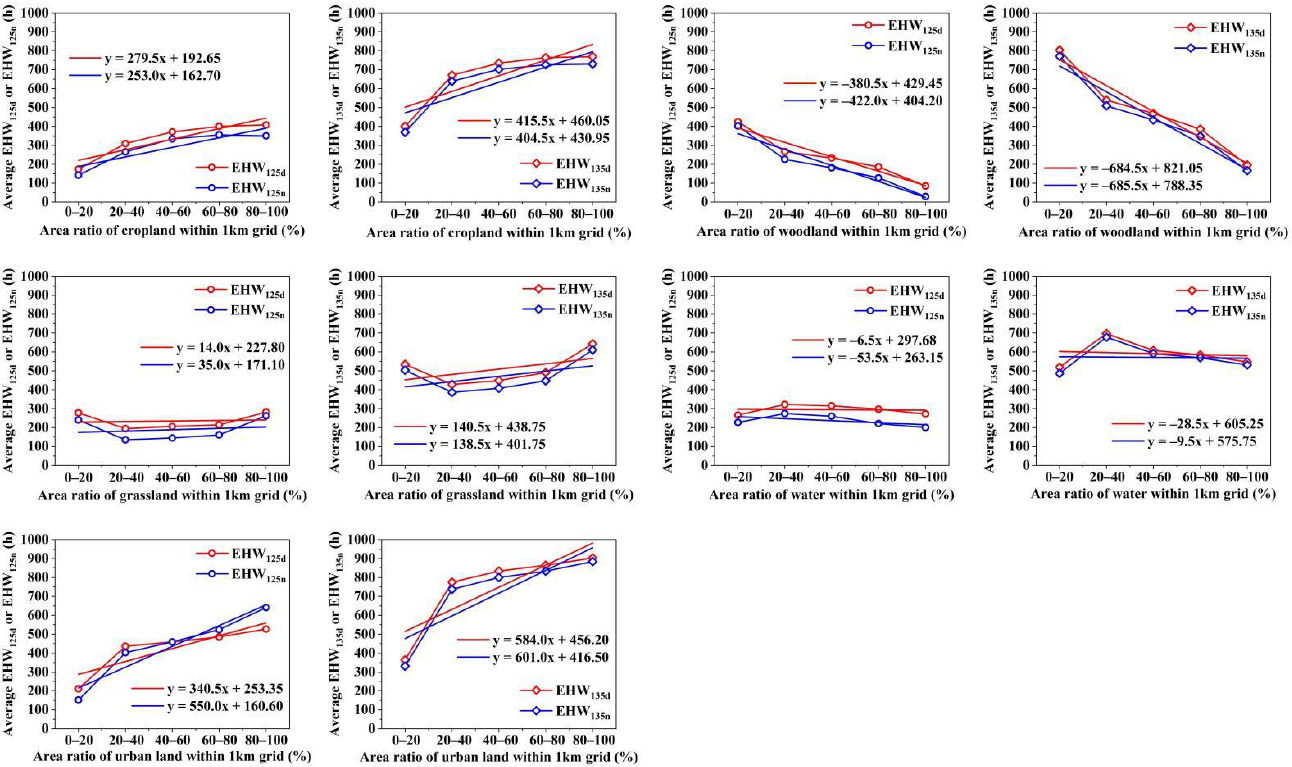
Figure 5. The EHWn changes (EHW 125d , EHW 125n , EHW 135d , and EHW 135n ) with the area increasing of different land-use types. The area was represented as area ratio of each land-use type within the regular grids.